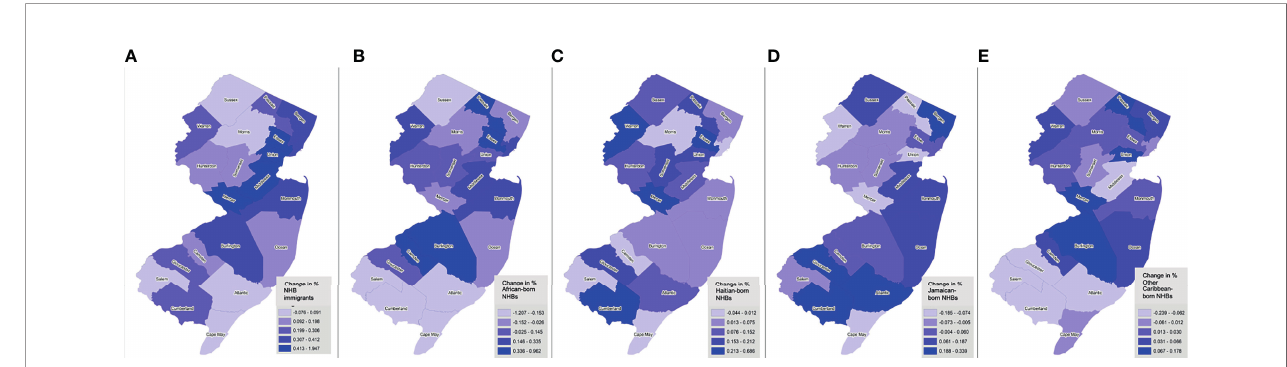
FIGURE 1 | Trends in NHB subgroup populations by birthplace across New Jersey counties, 2005-2017. Shown as change in percent of foreign-born NHBs (overall) (A) , African-born (B) , Haitian-born (C) , Jamaican-born (D) , and other Caribbean-born (E) , by